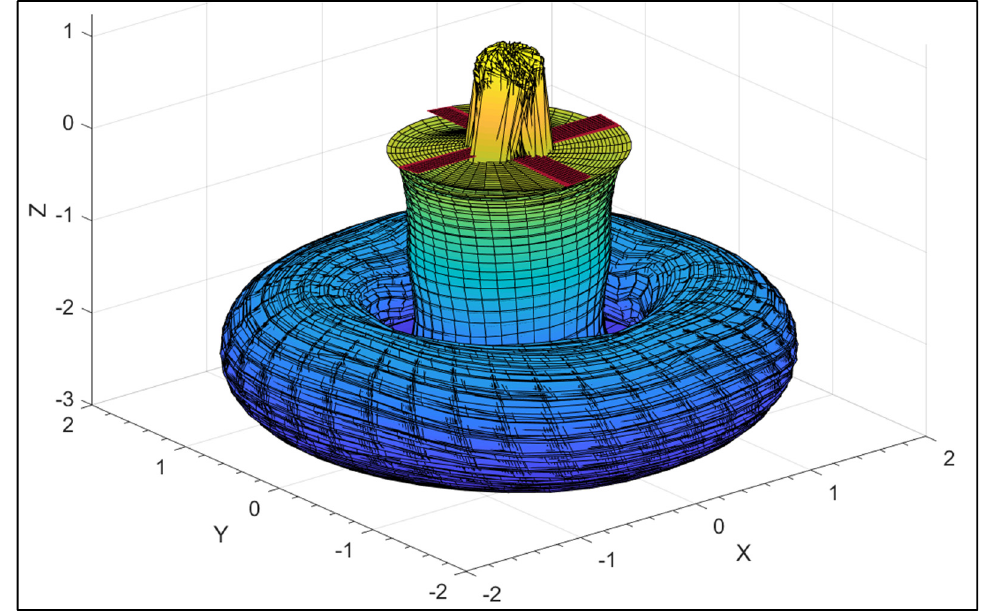
Figure 14. View of the symmetric wake produced by the four-blade rotor in hover.